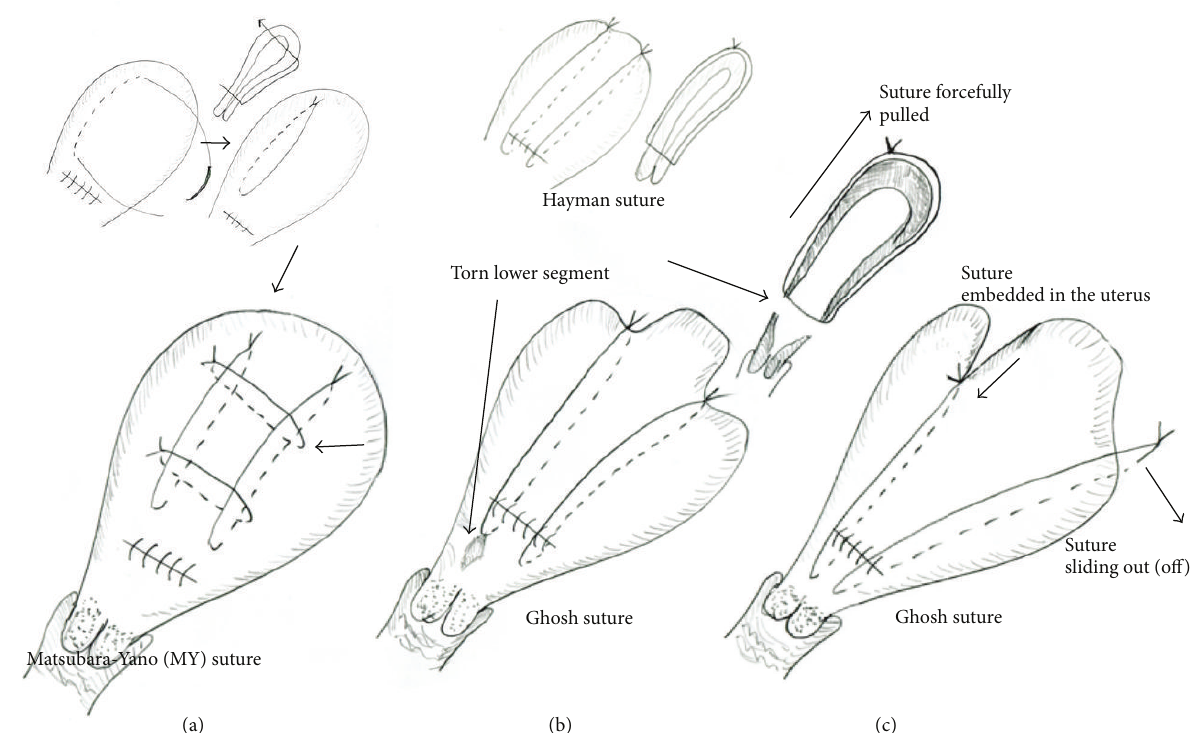
Figure 1: Schematic presentation of the Matsubara-Yano (MY) uterine compression suture (a) and possible drawbacks of the Ghosh suture (b, c). (a) The MY suture consists of two (or three) longitudinal transfixation sutures and two transverse sutures. Upper insets indicate how the first longitudinal transfixation suture is placed. Then, the transverse sutures are placed lateral to the longitudinal suture (arrow), thereby preventing the thread from sliding out (off). (b) Ghosh suture is a modification of Hayman suture (upper left insets). If the knot of a Ghosh suture is too tight, it may destroy the caudal insertion site (arrow), or the lower uterine segment, which is thin and weak. Upper right inset shows the sagittal view. (c) In the Ghosh suture, similar to the B-Lynch or Hayman suture, sutures may “slide out (off)” from the uterine fundus (left), thus yielding insufficient compression. If the knot is too tight, the chance of “sliding out” may be higher, since there may be no room for the suture to move. Even if it does not slide out, the thread may embed in the uterus (right), leading to uterine